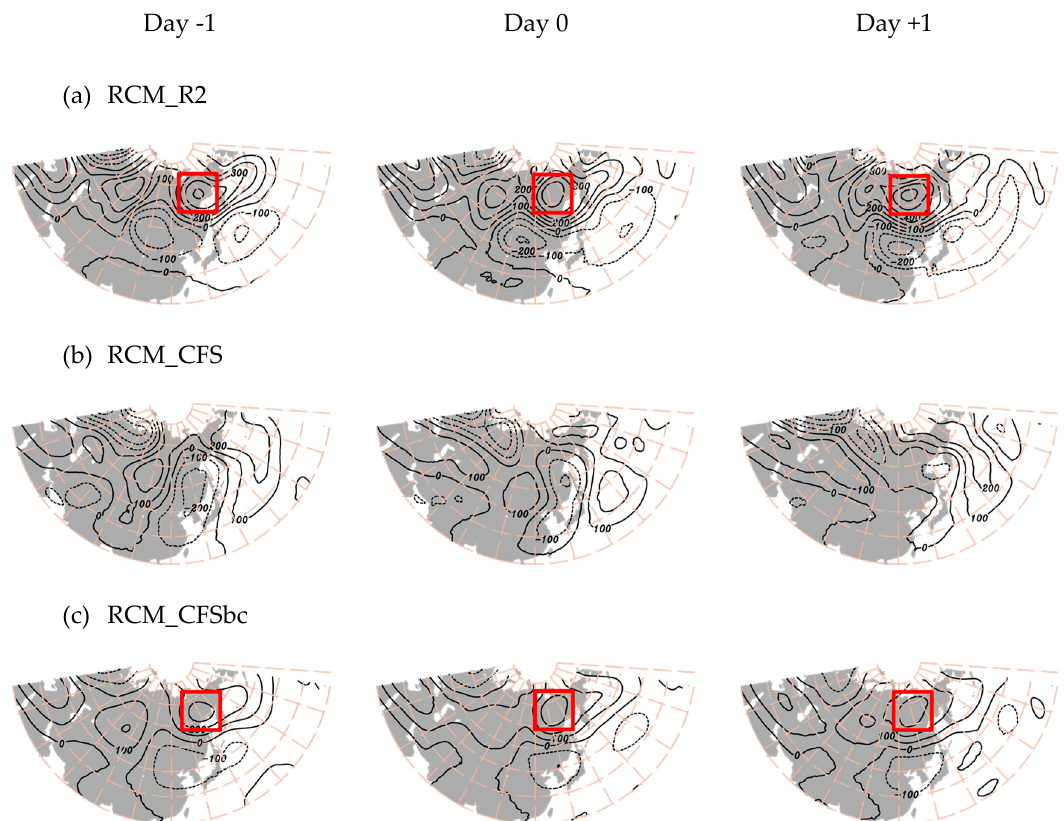
Figure 11. Geopotential height anomaly (gpm) at 300 hPa for ( a ) RCM_R2, ( b ) RCM_CFS, and ( c ) RCM_CFSbc experiment during − 1 day to + 1 day relative to the cold surge occurrence on 2 December 2005. Contour intervals are 100 m.